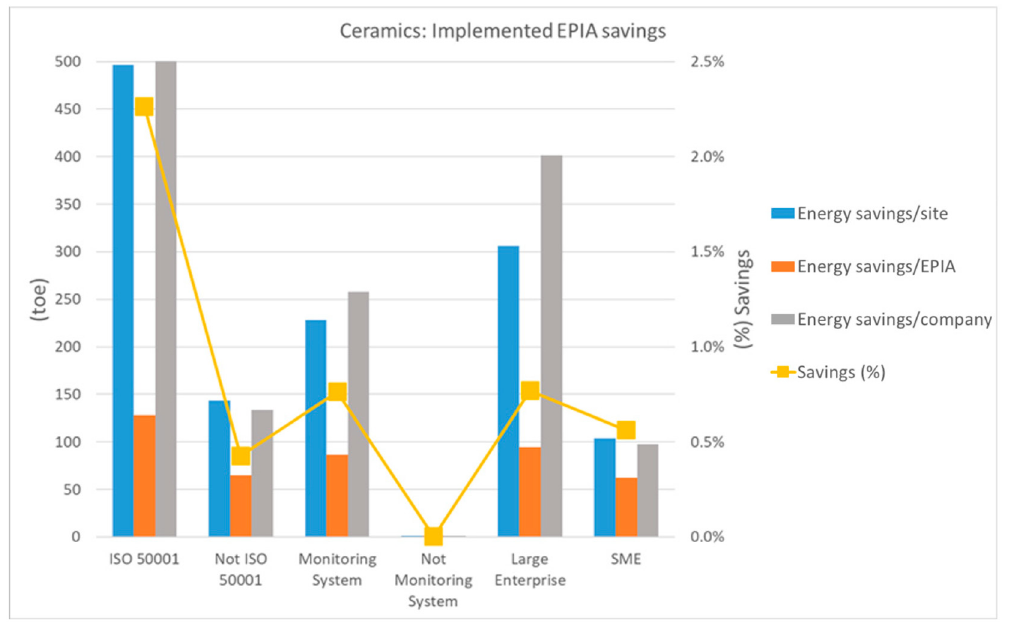
Figure 5. Ceramics: implemented EPIA savings.